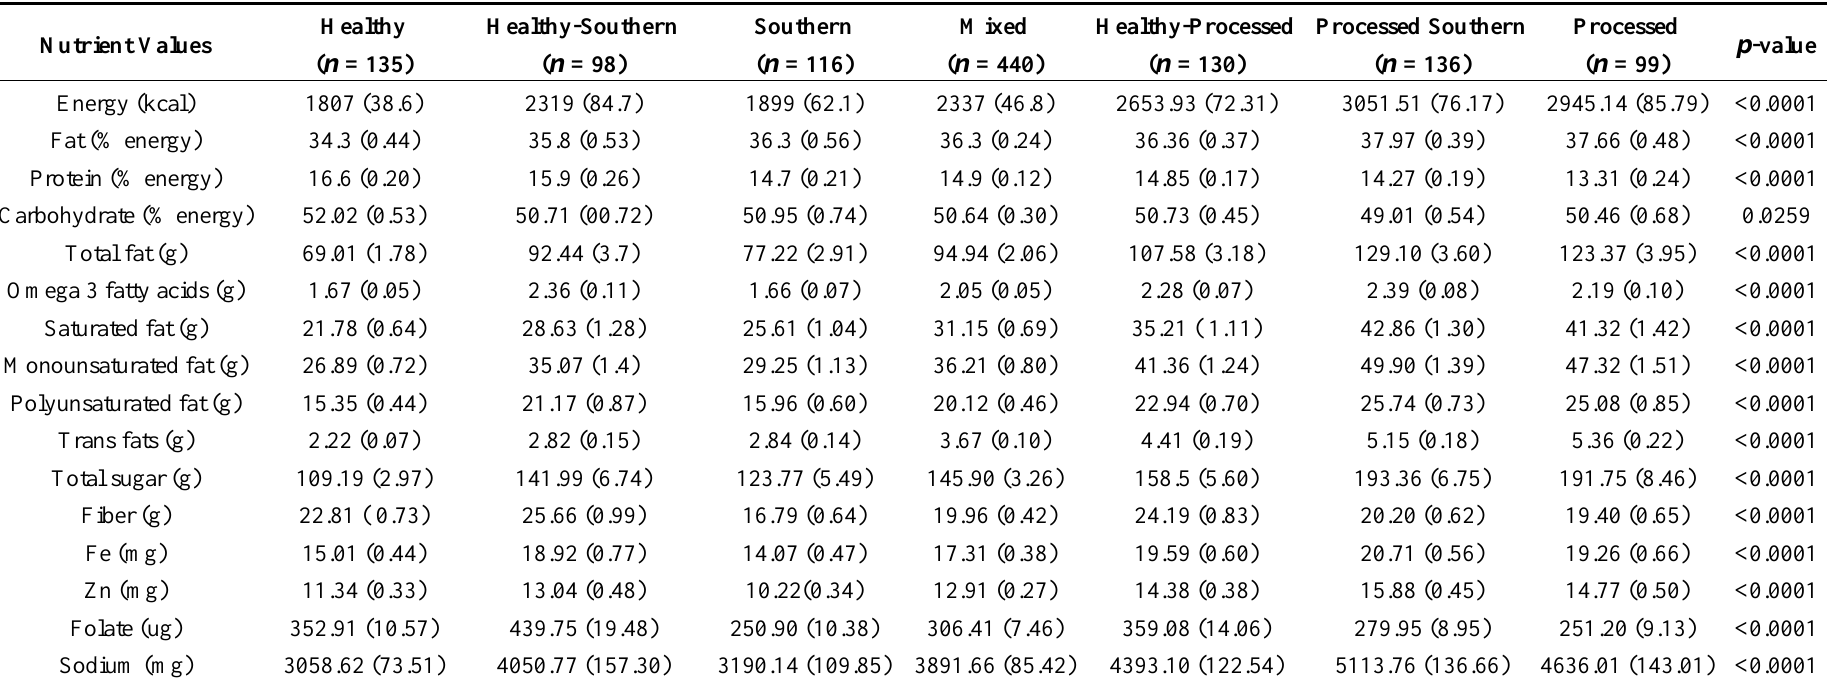
Table 1. Nutrient and MyPyramid values (per day) for dietary patterns in the Conditions Affecting Neurocognitive Development and Learning in Early Childhood (CANDLE) cohort. Values are means